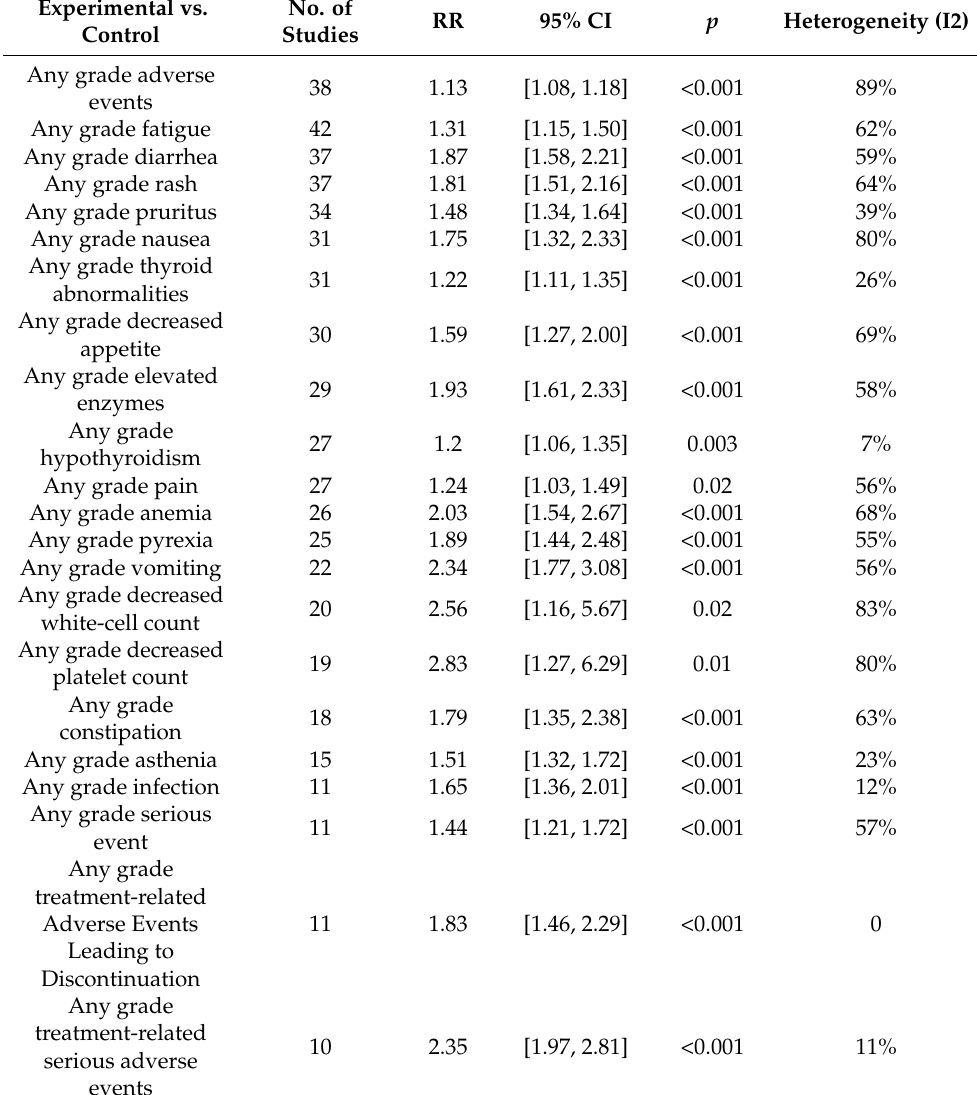
Table 4. Subgroup analysis of any grade adverse events. Experimental vs.